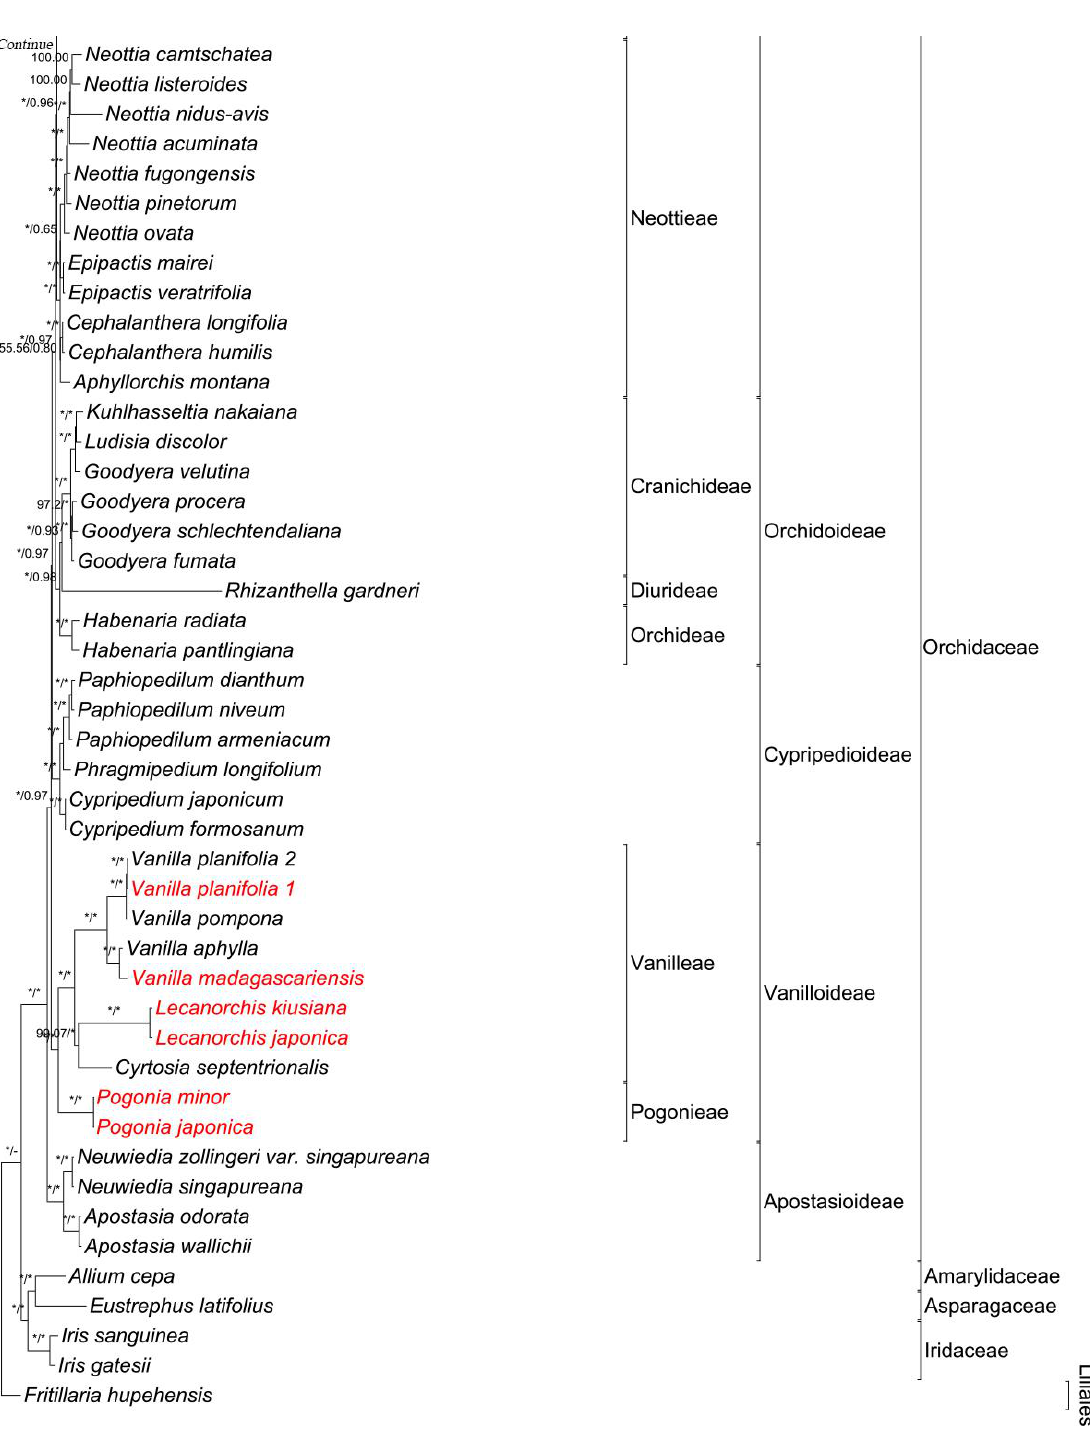
Figure 3. A maximum likelihood (ML) tree inferred from 89 species of Orchidaceae. The nucleotide sequences of 79 protein-coding genes and 4 rRNA genes were aligned individually and concatenated to be a single matrix. The aligned matrix was 87,230 bp, and the tree was reconstructed by RaxML with the GTR + G + I model ( − 563,601.727423 of ML value). The scientific names with red color indicate six newly decoded Vanilloideae species. This is an abbreviated tree, so the taxa of Cypripedioideae, Orchidoideae, and Epidendroideae are only given as a number of used species. The full tree structure is given in Supplementary Figure S3. An asterisk (*) indicates that 100% of bootstrap value or 1 of Bayesian posterior probability.